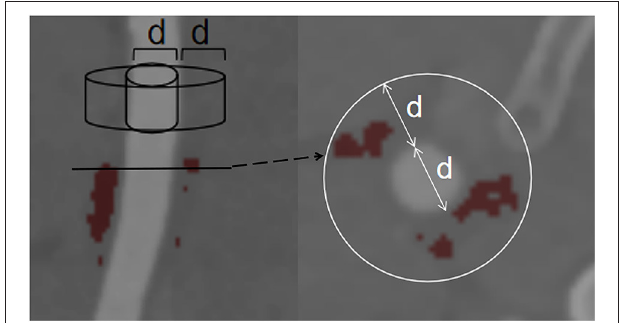
FIGURE 1 | Example of PVAT phenotyping around the carotid artery. Perivascular fat was defined as fat within a radial distance equal to the diameter (d) of the vessel. PVAT, perivascular adipose